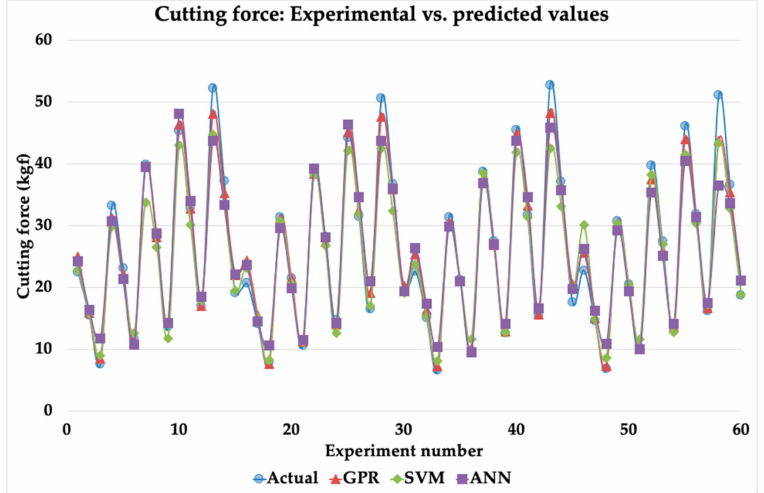
Figure 2. Actual cutting force values in comparison with predictions by GPR, SVM, and ANN methods.